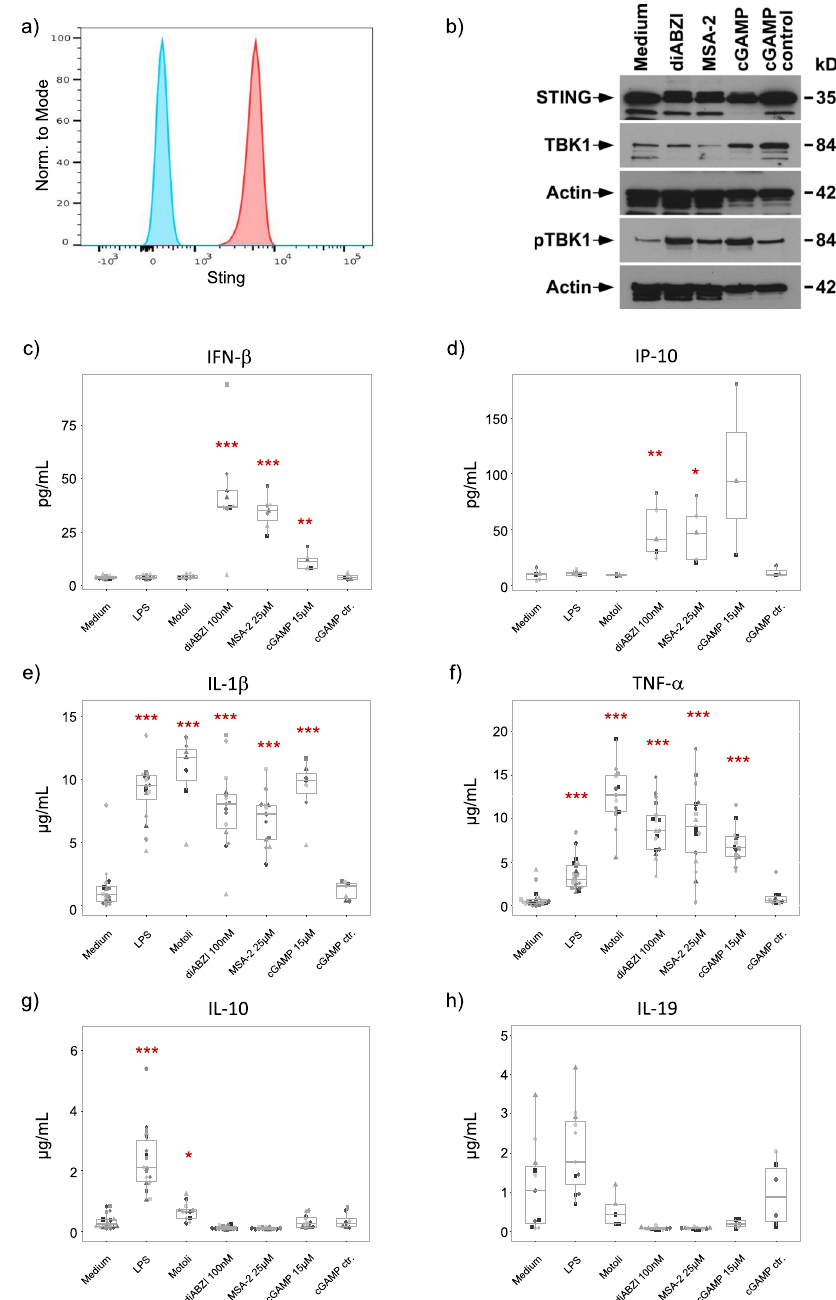
Figure 1. Responsiveness of monocytes to STING ligands. Purified monocytes were stimulated with 100 ng/mL LPS, 0.5 µg/mL Motolimod,100 nM diABZI, 25 µM MSA-2, or 15 µM cGAMP/cGAMP control as indicated. ( a ) STING expression in monocytes was analyzed by flow cytometry. Blue: FMO control, red: anti-STING-AF488. One representative out of five experiments. ( b ) Western blot analysis of monocyte lysates after 4 h stimulation. ( c – h ) Cytokines were quantified by ELISA in supernatants after 24 h. Each donor is identified by identical symbol and grey tone. ( c ) IFN-β (n = 5–9). ( d ) IP-10 (n = 3–5). ( e ) IL-1β (n = 7–18). ( f ) TNF-α (n = 10–22). ( g ) IL-10 (n = 8–20). ( h ) IL-19 (n = 5–12). Statistical significance was calculated for each group by comparing stimulatory conditions with medium by paired Student’s t-test or Wilcoxon signed rank test as appropriate. Red asterisks indicate the level of significance between stimulated and unstimulated (medium) samples. *p < 0.05, **p < 0.01, ***p <